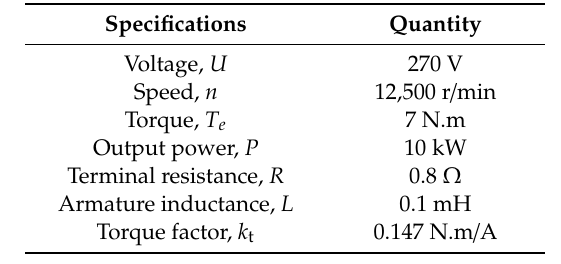
Table 2. The BLDC machine specifications.